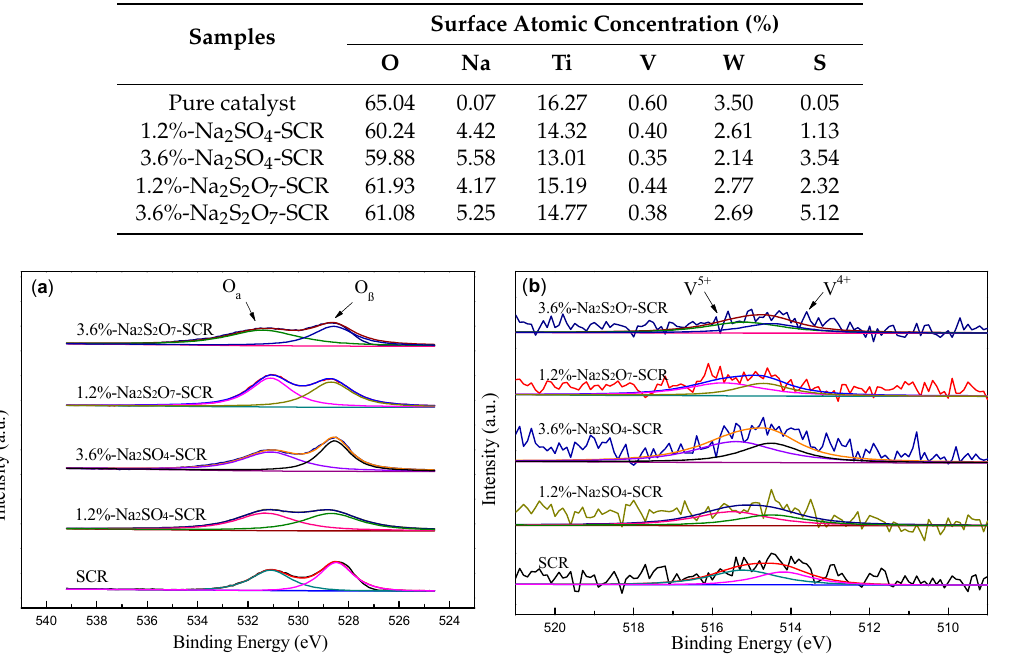
Table 1. The surface atomic concentrations for these samples.